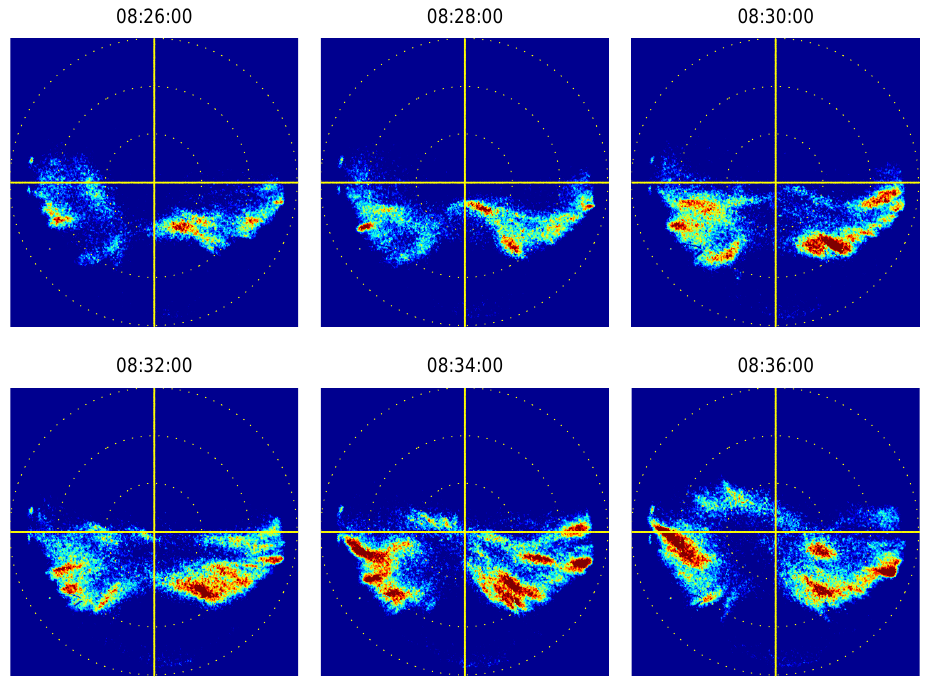
Figure 18 Fig. 18. Ny ˚Alesund ASC observations at 630.0nm for the interval 08:26–08:36 UT on 12 December 1999. The reference frame is zenith angle (dotted circles at 30, 60, and 90 ◦ ) and azimuth. Same format as in Fig. 4. The integration time is